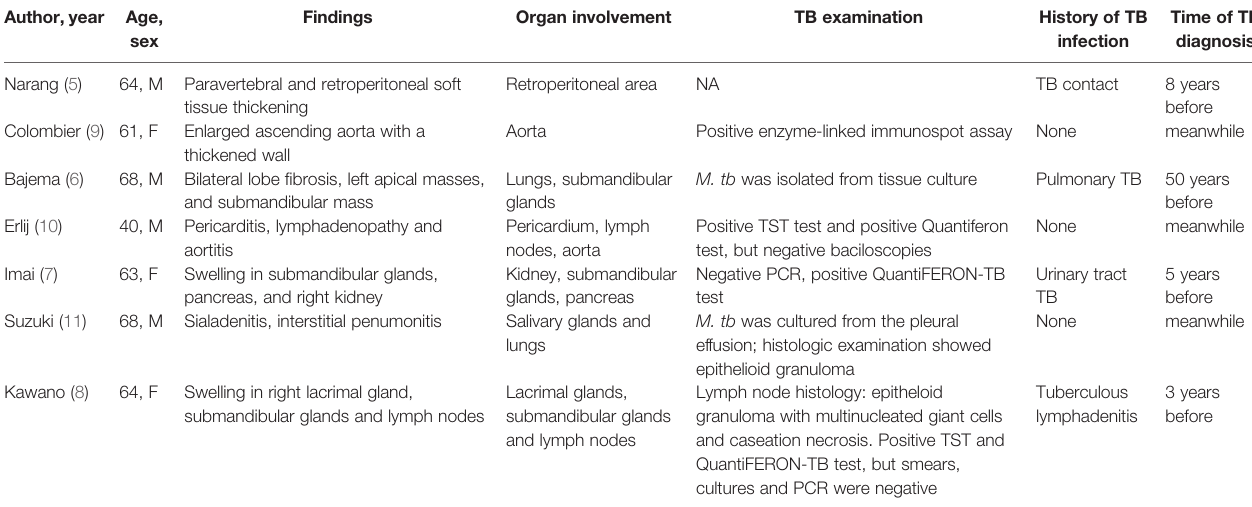
TABLE 1 | Case review of IgG4-related disease associated with